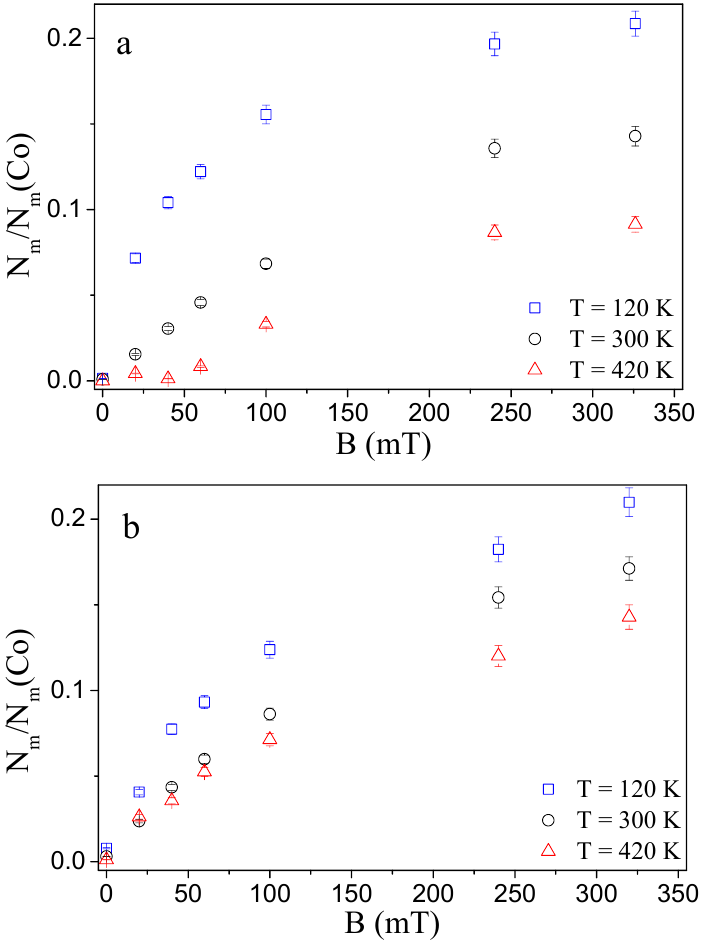
Figure 9. Magnetic field dependence of fitted magnetic SLD value N m normalized to magnetic SLD of bulk cobalt N m (Co) for the ferromagnetic films SiO 2 (70 at.% Co) ( a ) and SiO 2 (60 at.% Co) ( b